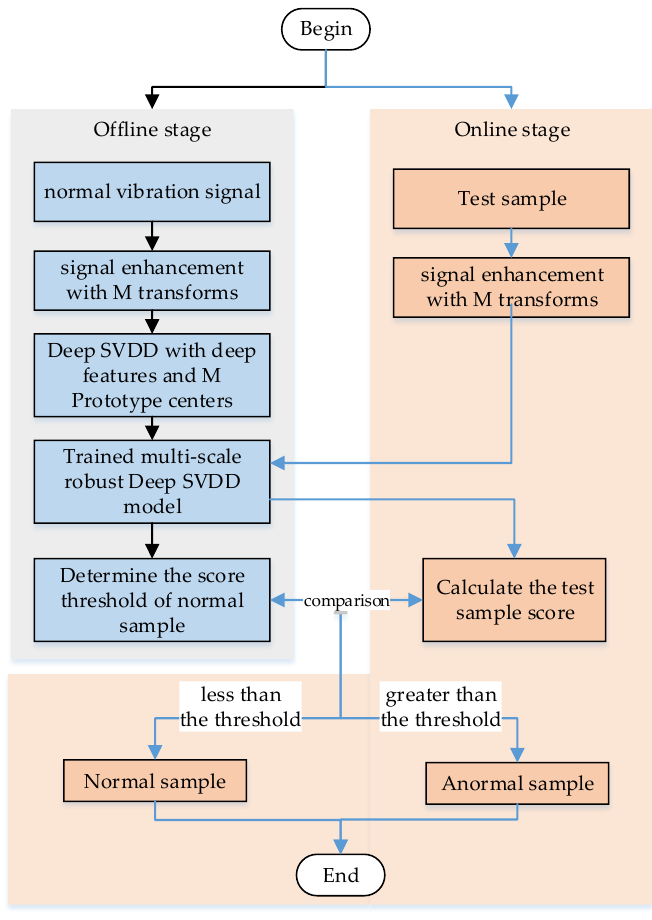
Figure 1. Flowchart of the Robust Multi-scale Deep-SVDD